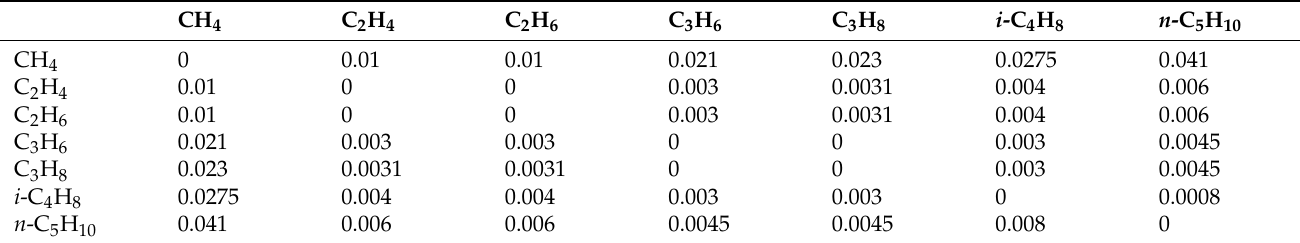
Table A1. Binary interaction parameters.